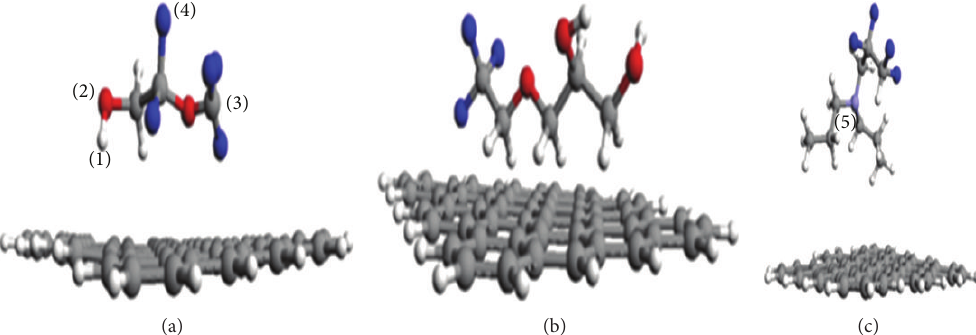
Figure 7: The relaxed PFP-graphene dimers for (a) Z-dol, (b) Z-tetraol, and (c) DDPA. White = hydrogen, red = oxygen, grey = carbon, blue = fluorine, and violet =